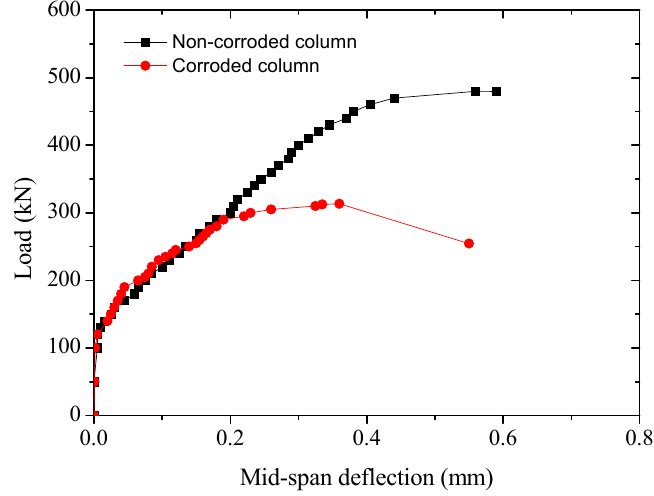
Figure 9. Load-mid-span flexural deflection response of RC